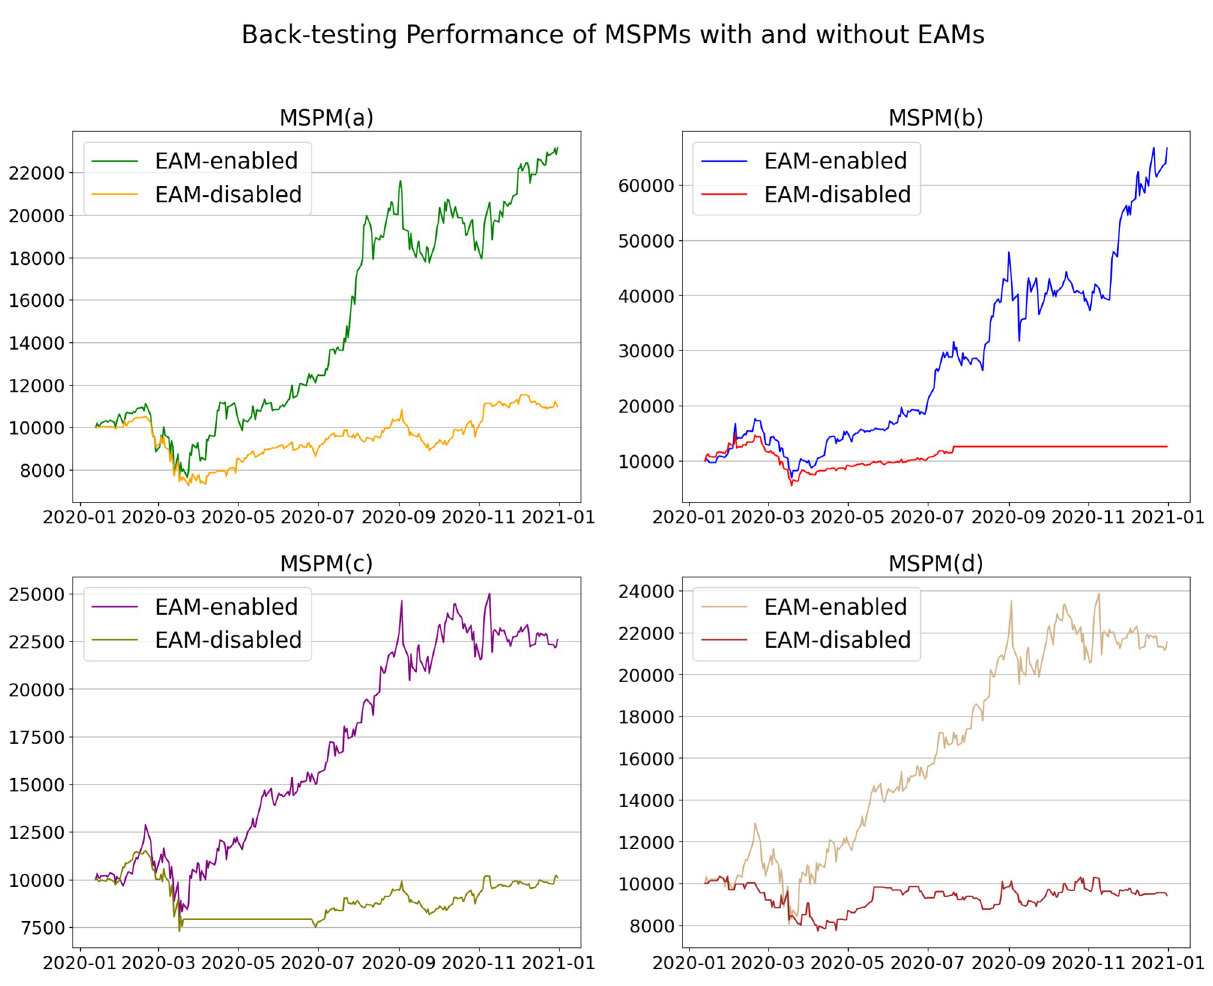
Fig 16. Accumulated portfolio values of MSPMs, with and without EAMs, from back-testing for portfolio (a), (b), (c) and (d). For all the four portfolios, EAM-enabled MSPMs perform significantly better than EAM-disabled MSPMs.